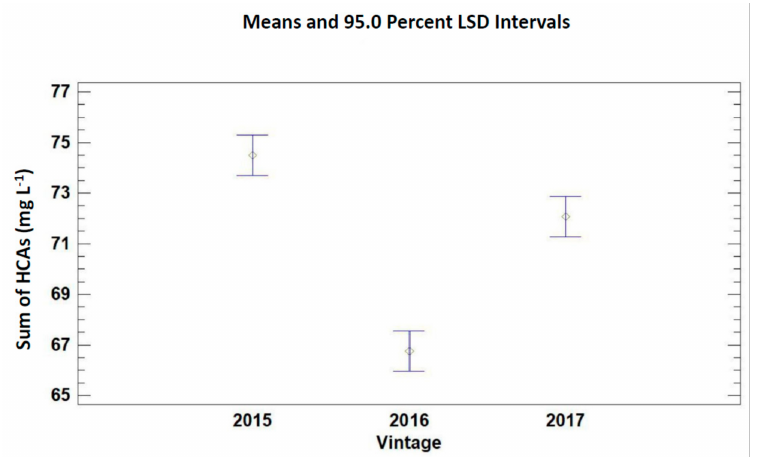
Figure 6. Significant differences in the Chardonnay variety in the vintages 2015–2017 based on the sum of the hydroxycinnamic acids (HCAs).